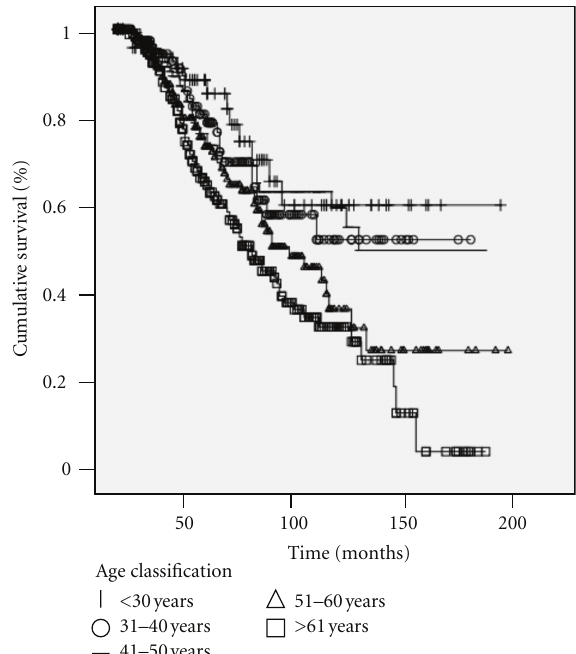
Figure 1: Increased age is associated with poorer survival ( P = 0 .